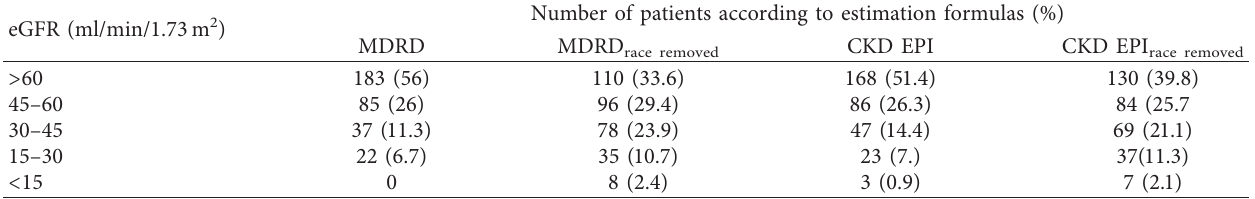
Table 2: CKD staging of patients according to the respective eGFR formulas from a cohort of 327 AA patients.